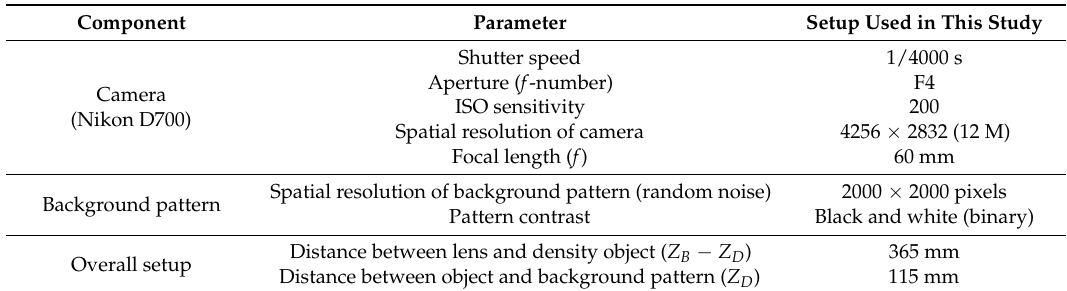
Table 1. Summary of parameters for the BOS measurement